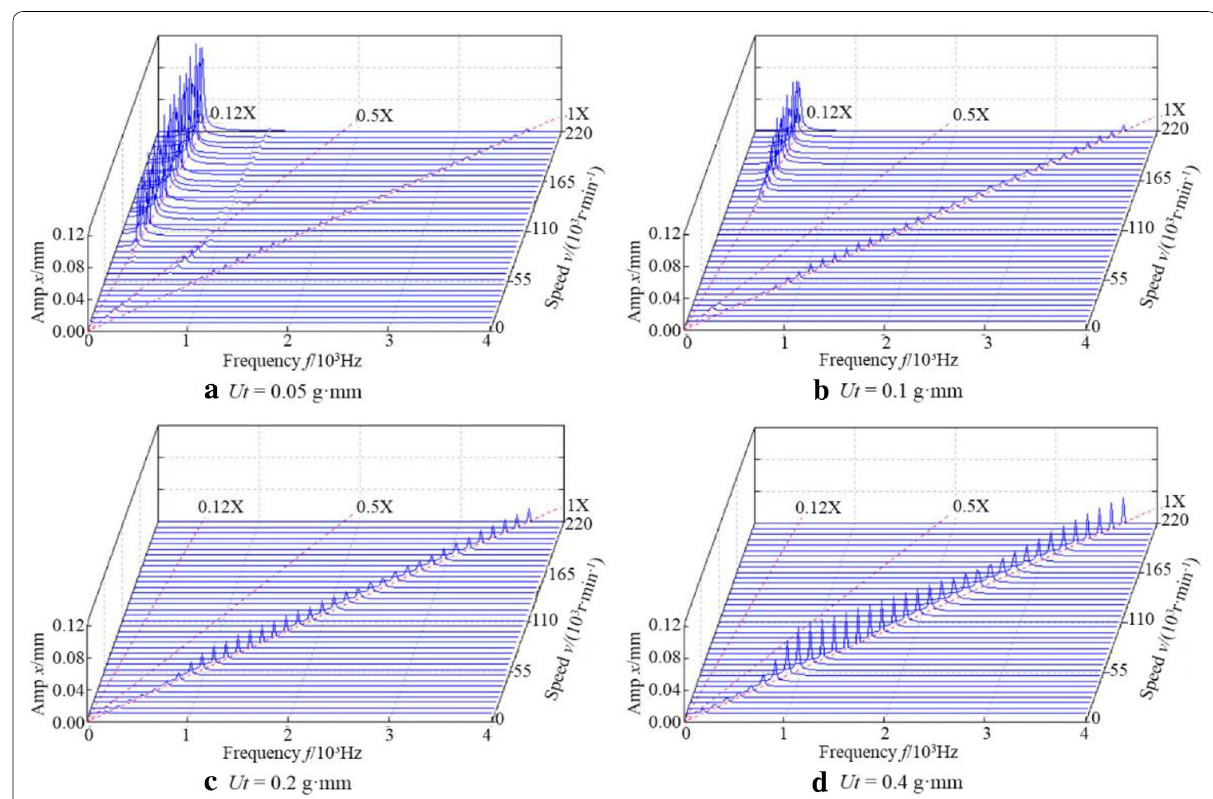
Figure 8 Waterfall plots of stn 20 for four difference unbalance amplitudes in CW nose of